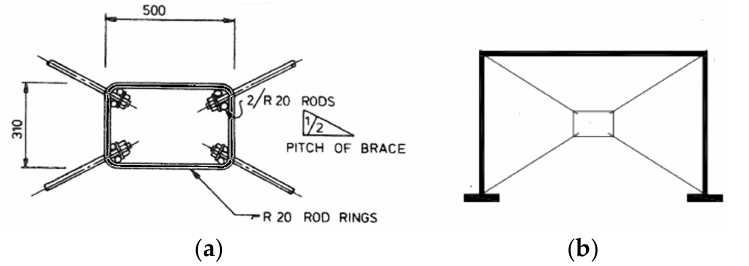
Figure 8. Premier metallic damper. ( a ) description of the rectangular metallic damper, ( b ) one story frame with the metallic damper.